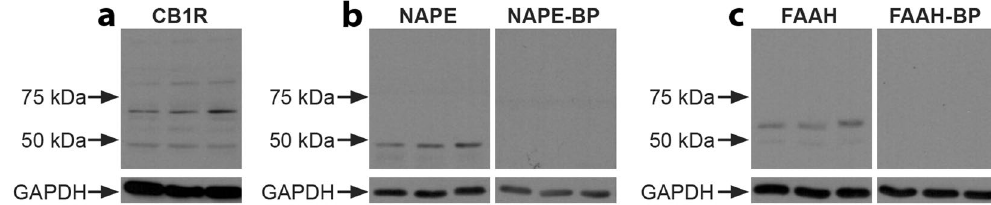
Figure 1. Presence of CB1R, NAPE-PLD, or FAAH in the NAc of three vervet monkeys. WB analysis of total protein samples for the CB1R antibody ( a ) showing detection of the expected major protein band at 60 kDa. For the NAPE-PLD antibody ( b ), the expected band is seen at 46 kDa, and not detected when pre-incubated with its blocking peptide. For the FAAH antibody ( c ), the expected band is seen at 63 kDa, and not detected when pre-incubated with its blocking peptide. All lanes contained 10 µ g of total protein. The lower blots show the expression of GAPDH and demonstrate loading in all